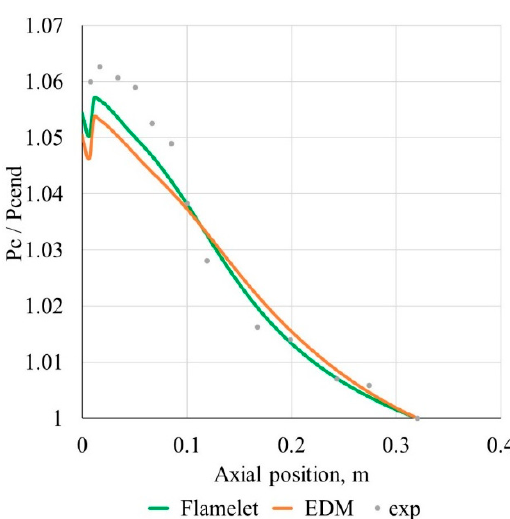
Figure 6. Normalized axial pressure distribution.